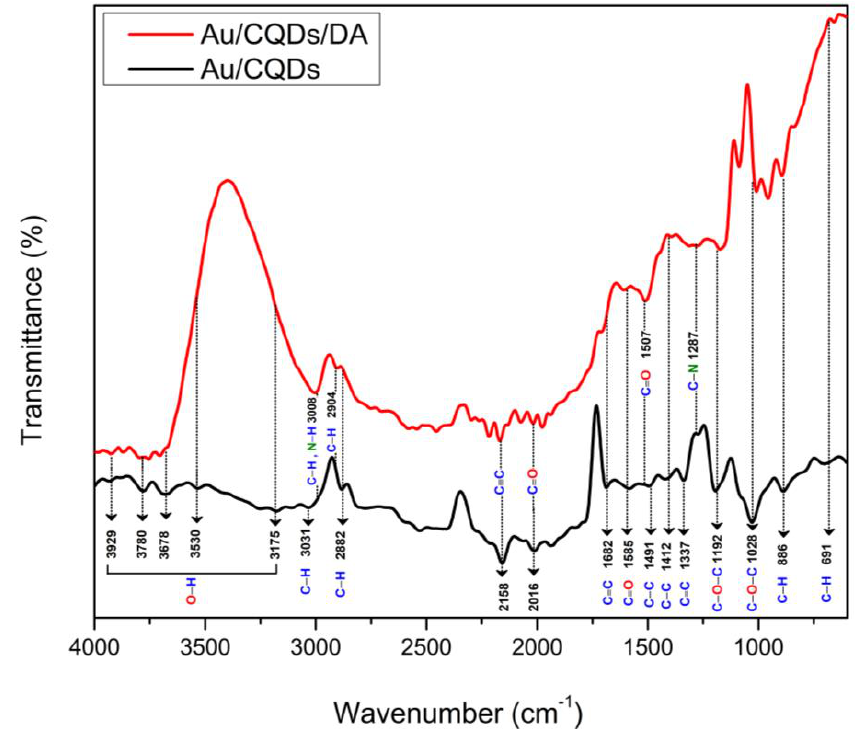
Figure 2. FTIR spectrum of CQD thin film before and after interaction with DA.